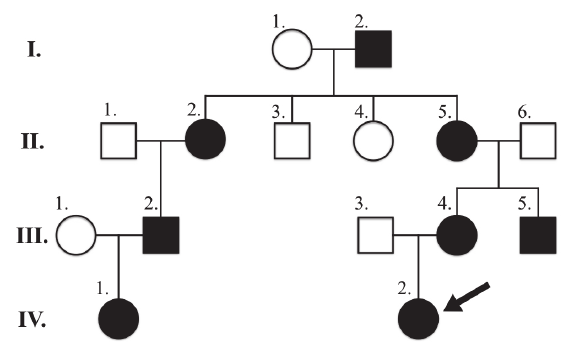
Fig. 1. Pedigree of Family 1. The family comprised four af- fected members in three generations. Roman numerals (I-III) give the generation, arabic numerals (1-3) state the individu- als within one generation. Square - male, circle - female, filled symbol - affected subject, blank symbol - unaffected subject, arrow - proband.